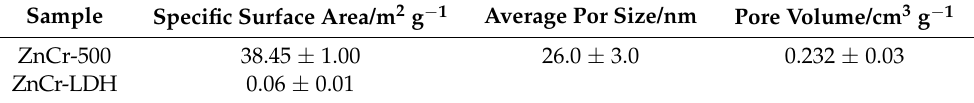
Table 1. Specific surface area, pore size and pore volume for ZnCr-LDH and ZnCr-500